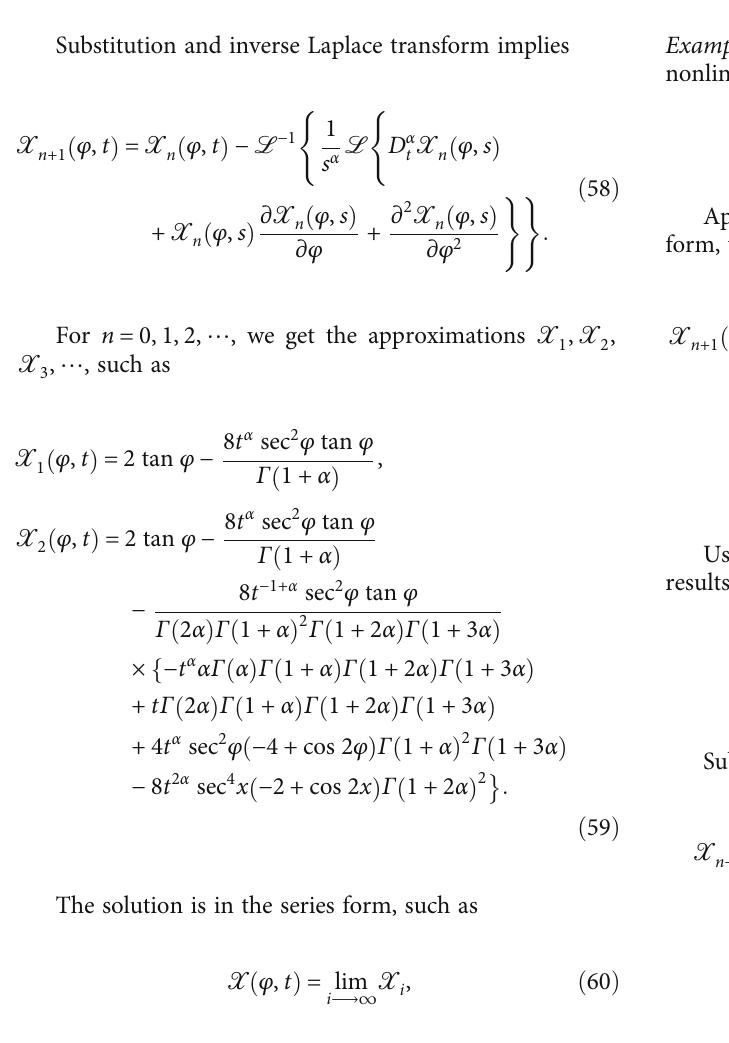
Figure 3: 3D representation of X for α = 0 : 2 (a) and α = 0 : 5